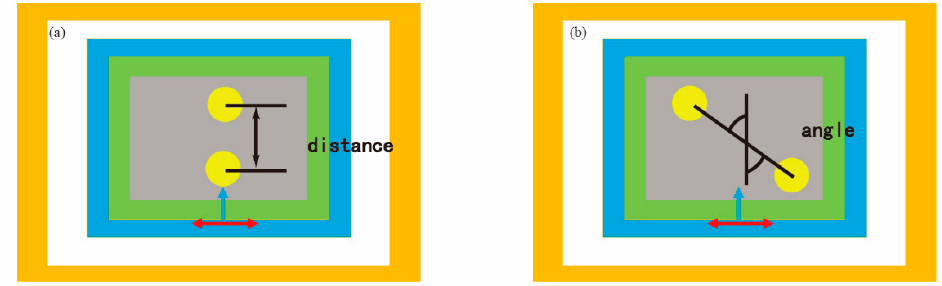
Figure 2. Schematic of the simulation model. ( a ) Double particles with different distance. ( b ) Double particles with different angles.